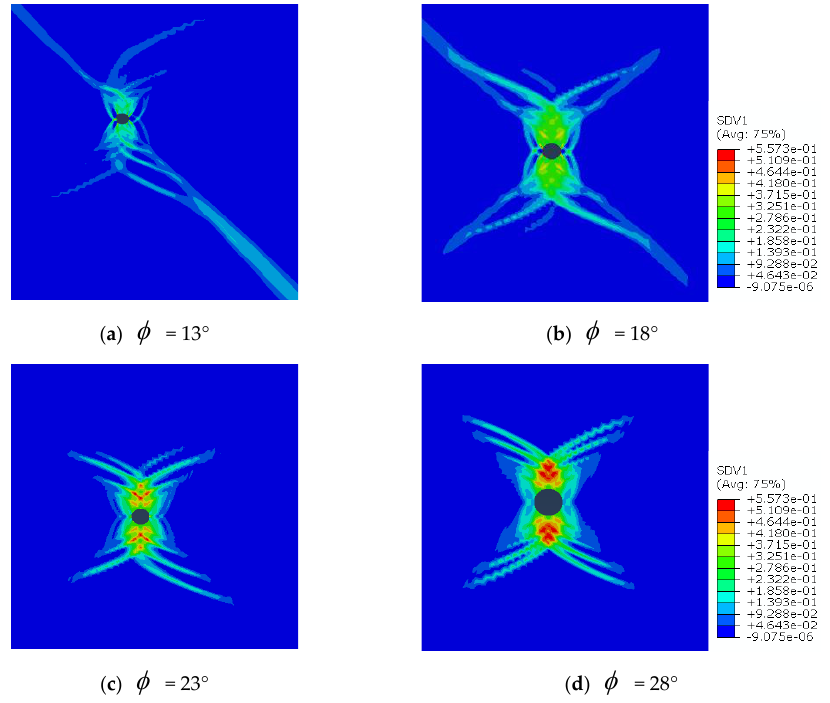
Figure 9. Evolution of equivalent plastic strain region. The cloud picture of the damage factor around the borehole under different internal friction angles of rock is shown in Figure 10. As the internal friction angle, the damage area increases, and the bifurcation characteristics are enhanced. Under the friction angle of 28°, an obvious bifurcation occurs in the y direction, and the damage degree approaches 1, indicating shear collapse failure around the borehole. Under the low internal frictional angles, a narrow and long damaged area occurs in the sub-diagonal direction.